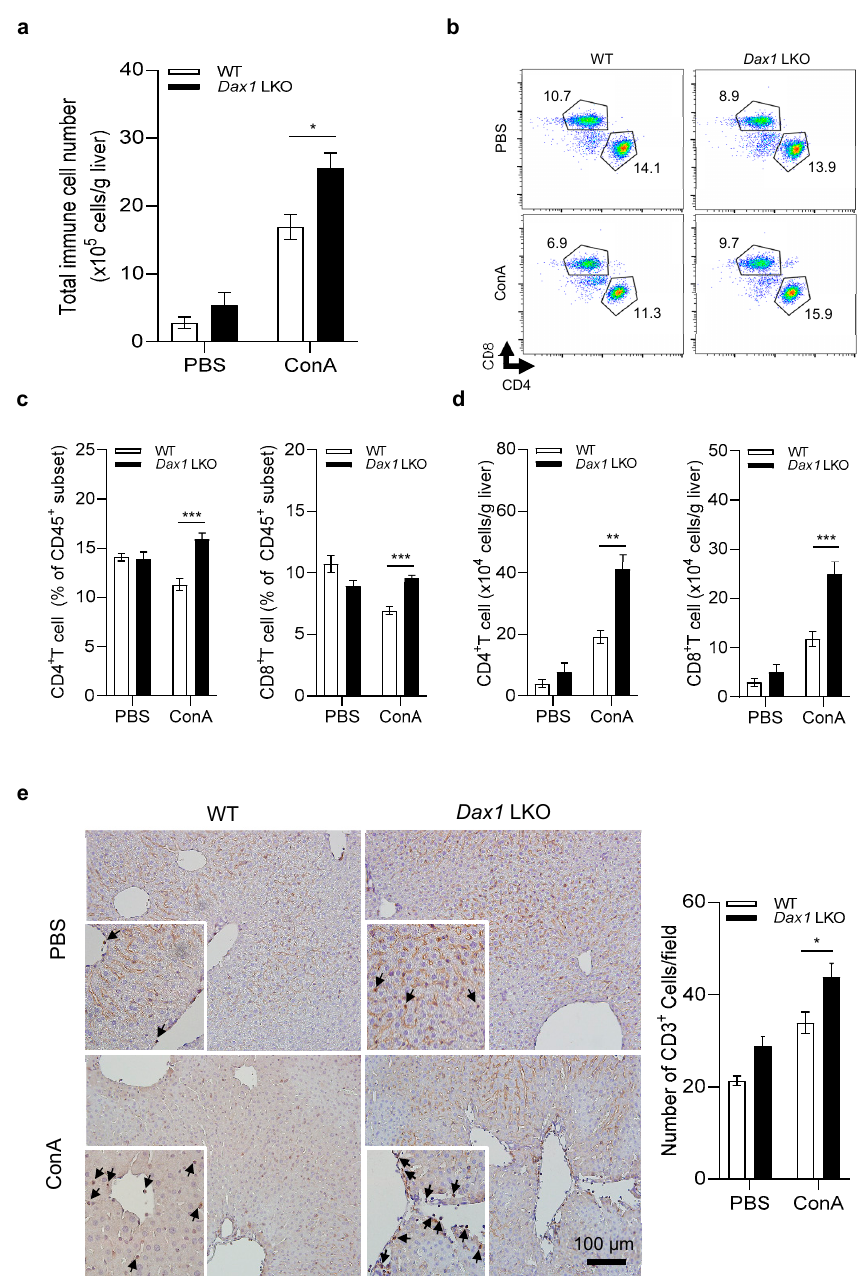
Figure 4. Hepatocyte ‐ specific DAX1 deletion elevates CD4 + helper and CD8 + cytotoxic T ‐ cell recruitment to the liver following ConA administration. WT and Dax1 LKO mice were treated with a single administration of ConA (15 mg/kg, i.v.) or PBS. lntrahepatic immune cells were isolated at 6 h (PBS; n = 3, ConA; n = 6) post treatment and analyzed via fluorescence ‐ activated cell sorting. Cell surface markers, including CD45, CD3e, CD4, and CD8a, were used to characterize CD4 + and CD8 + T cells. ( a ) Absolute number of whole liver immune cells (CD45 + ). ( b , c ) The percentages of CD4 + T cells (CD45 + CD3 + CD4 + ) and CD8 + T cells (CD45 + CD3 + CD8 + ) were determined, and the representative scatterplots are shown. ( d ) Absolute number of CD4 + T cells (CD45 + CD3 + CD4 + ) and CD8 + T cells (CD45 + CD3 + CD8 + ) were determined. ( e ) Immunohistochemical liver staining for T cells (CD3, arrows) was conducted, and representative images are shown. CD3 + cells were counted in 4 randomly selected fields. Data are expressed as the mean ± SEM. Tukey–Kramer test after the one ‐ way ANOVA was used to compare the ConA ‐ treated LKO and ConA ‐ treated WT groups; * p < 0.05, ** p < 0.01, and *** p < 0.001.